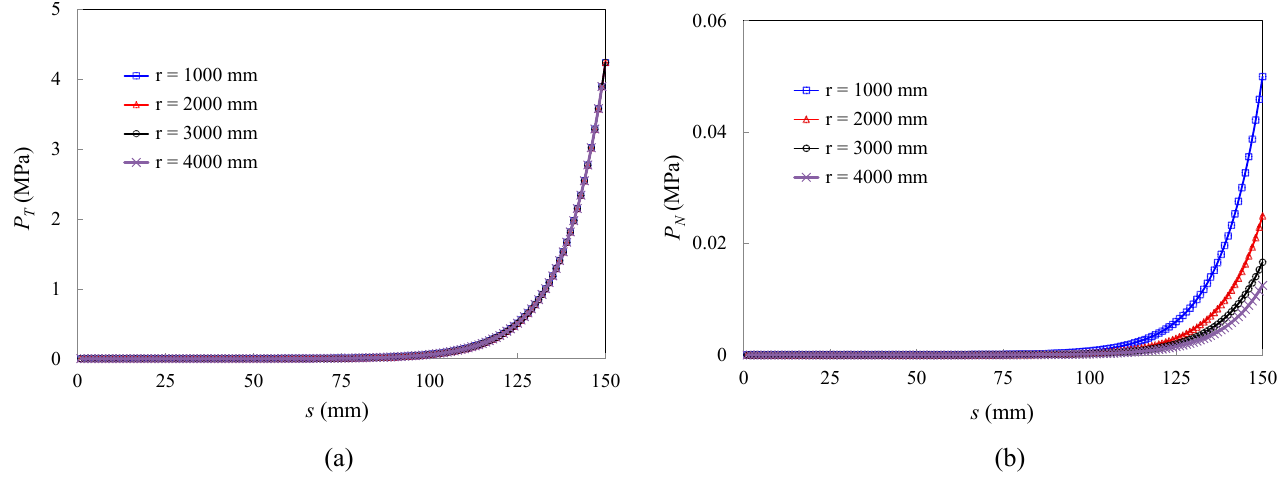
Figure 3. Analytical results of the interface stresses: ( a ) circumferential stress; ( b ) radial stress.